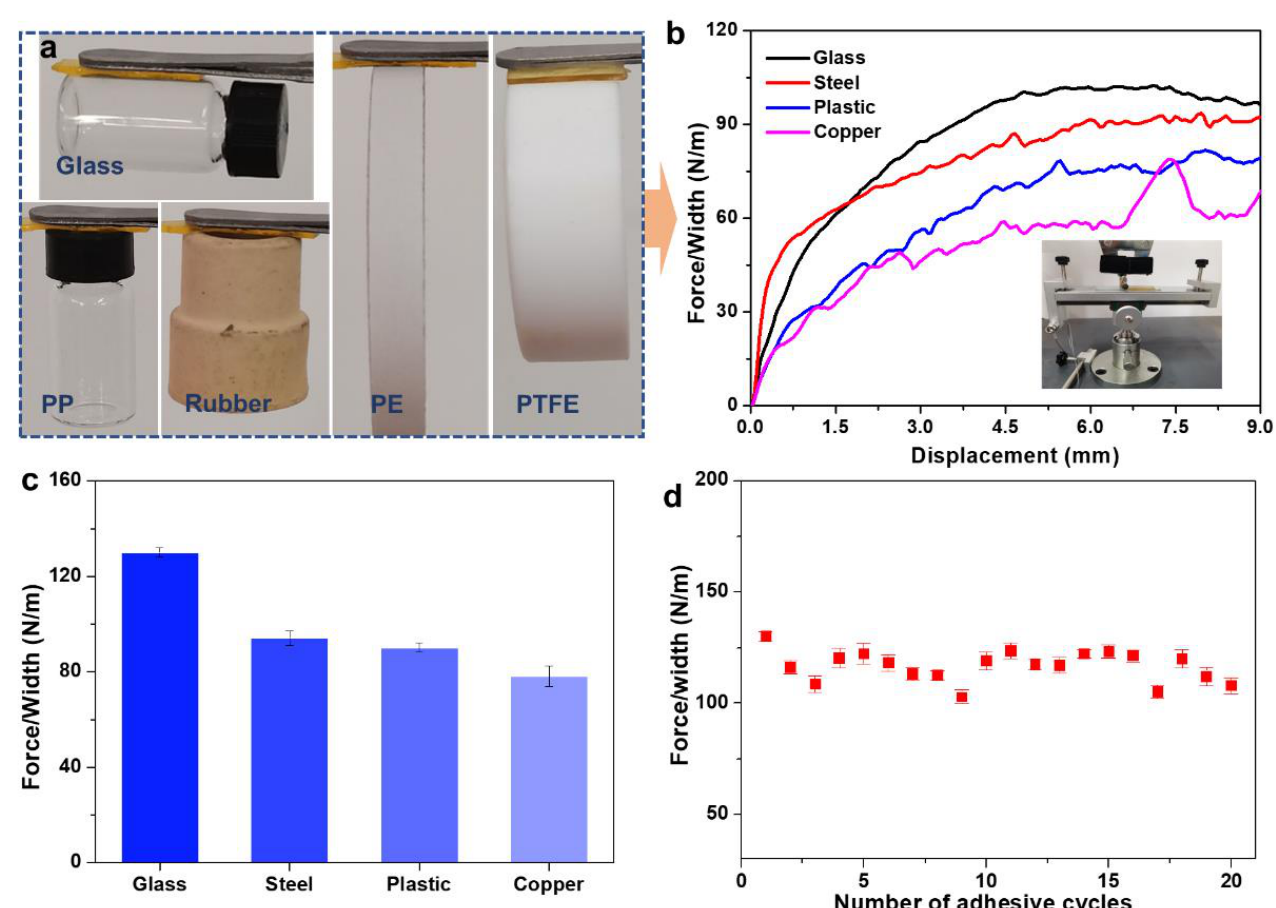
Figure 3. Optical images of adhesion of the CS/PAA DN ionogel to different materials (glass, PP, PE, rubber and PTFE) ( a ); force-displacement curve ( b ) and adhesion force ( c ) to different materials measured by 90° peeling tests; adhesion force of the CS/PAA DN ionogel to glass slide measured by 90° peeling test for 20 cycles ( d ).